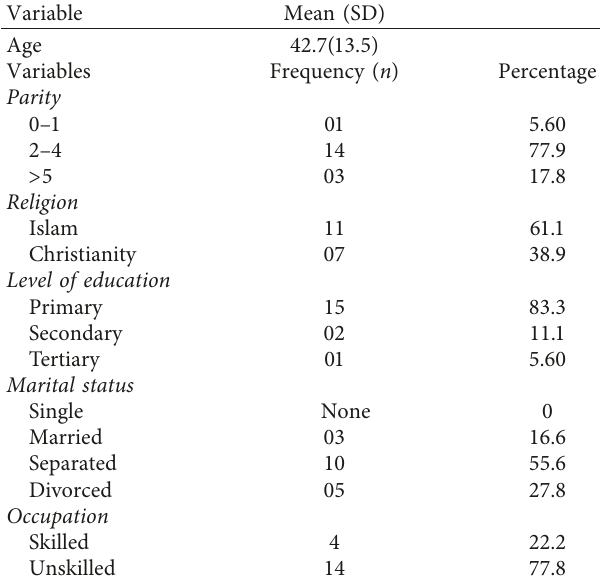
Table 2: Clinical features. Table 1: Sociodemographic